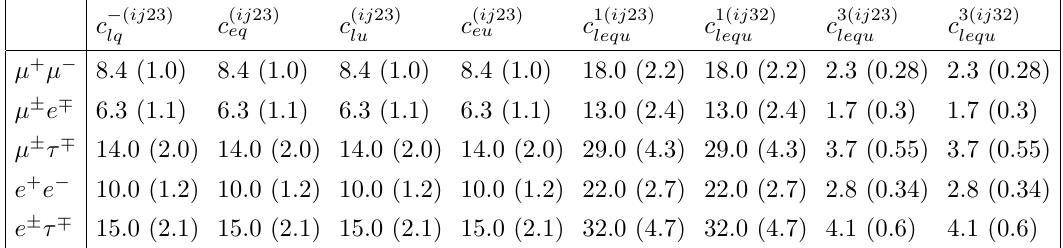
Table 6 . Current (future) bounds on c for (cid:3) = 1 TeV. The choice of the lepton (cid:13)avour indices i; j depend on the process t ‘ + ‘ (cid:0) c , as indicated in the (cid:12)rst column. In the case of LFV decays we i j ! assume c ijkl = c jikl . The future bounds become a factor of on the background of 10 %. (cid:24)